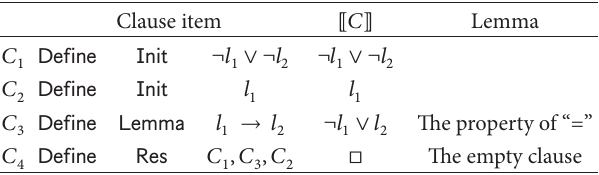
Table 1: A certificate